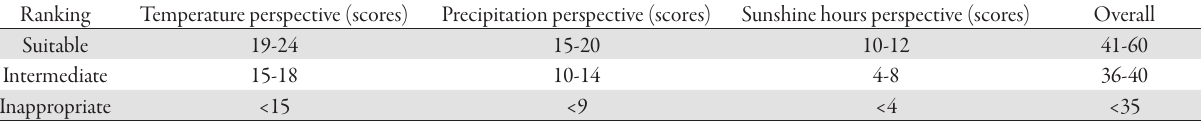
Tab. 6. Descriptive ranking of climatic factors by rating scores